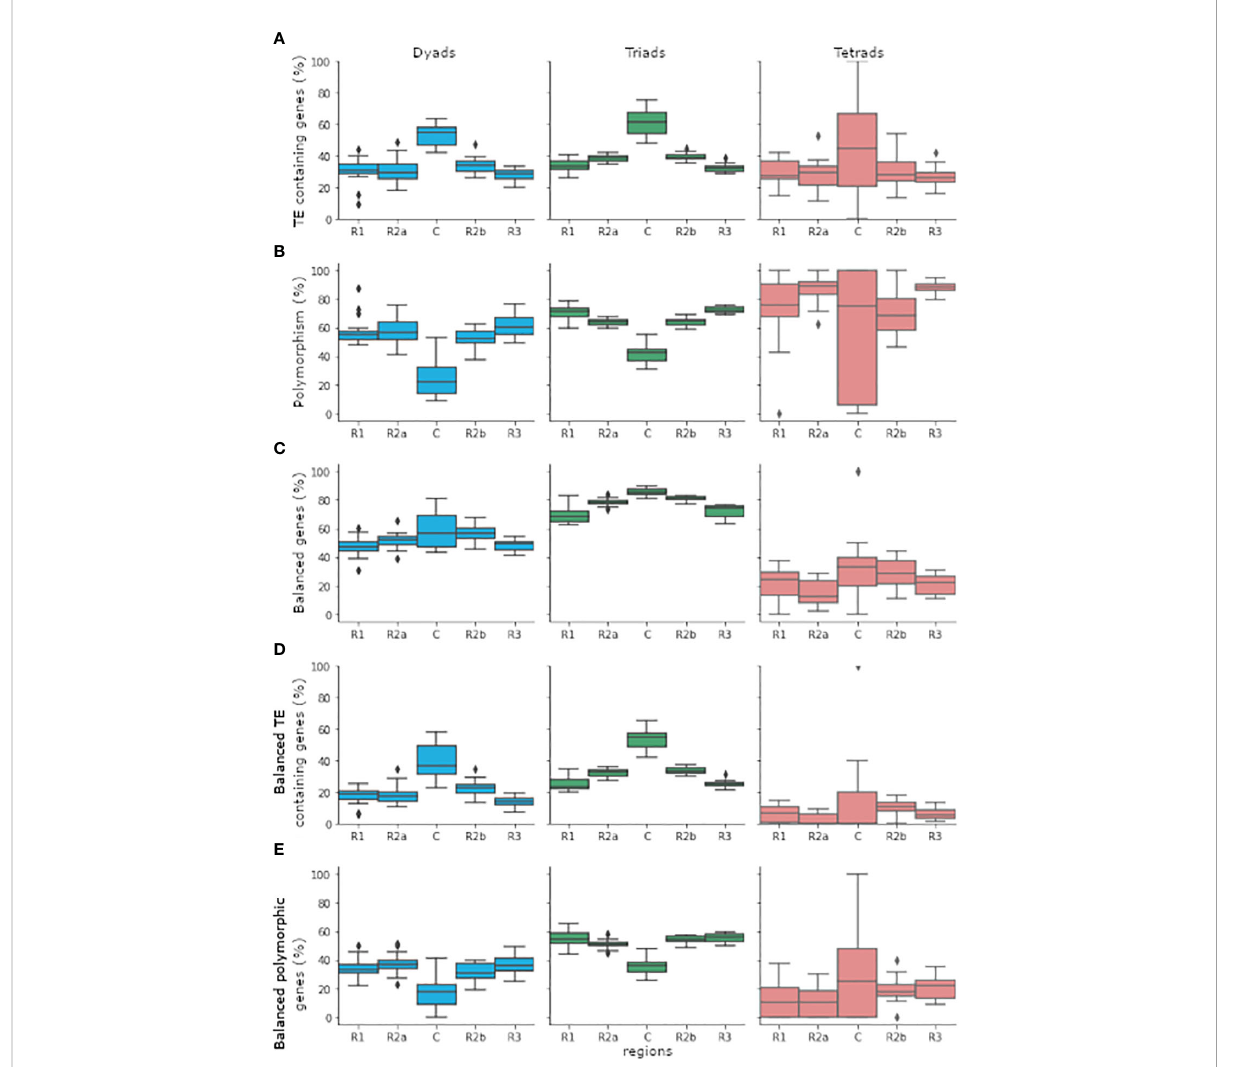
FIGURE 1 The distribution of genes belonging to the dyads, triads, or tetrads categories in the fi ve chromosomal regions (R1, R2a, C, R2b, and R3). Gene distribution was calculated individually for genes that belong to the same category and found in the same and chromosomal region in each one of 18 bread wheat chromosomes. Genes found in chromosomes 1A, 1B, and 1D were eliminated from the analysis due to the lack of tetrads genes in the centromeres of chromosomes 1A and 1B. (A) Percentage of TE containing genes out of total genes. (B) Percentage of genes belonging to polymorphic group out of genes that found in TE containing group. (C) Percentage of genes belonging to balanced group out of total genes. (D) Percentage of genes belonging to balanced group out of genes that found in TE containing group. (E) Percentage of genes belonging to balanced and polymorphic group out of genes that found in TE containing group. The boxplots depict the fi rst quartile (Q1) and the third quartile (Q3) of the data with the median between them. The whiskers extend from the box to 1.5x the interquartile range (IQR). Rhombuses represent values found past the end of the whiskers. boxplots were drawn using the boxplot function from the seaborn python package (Waskom,